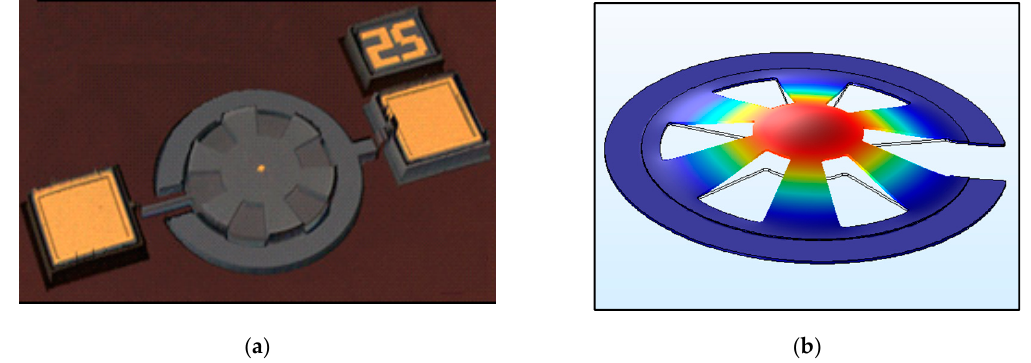
Figure 8. Cross-section of the micro-resonator with oxide as sacrificial layer.